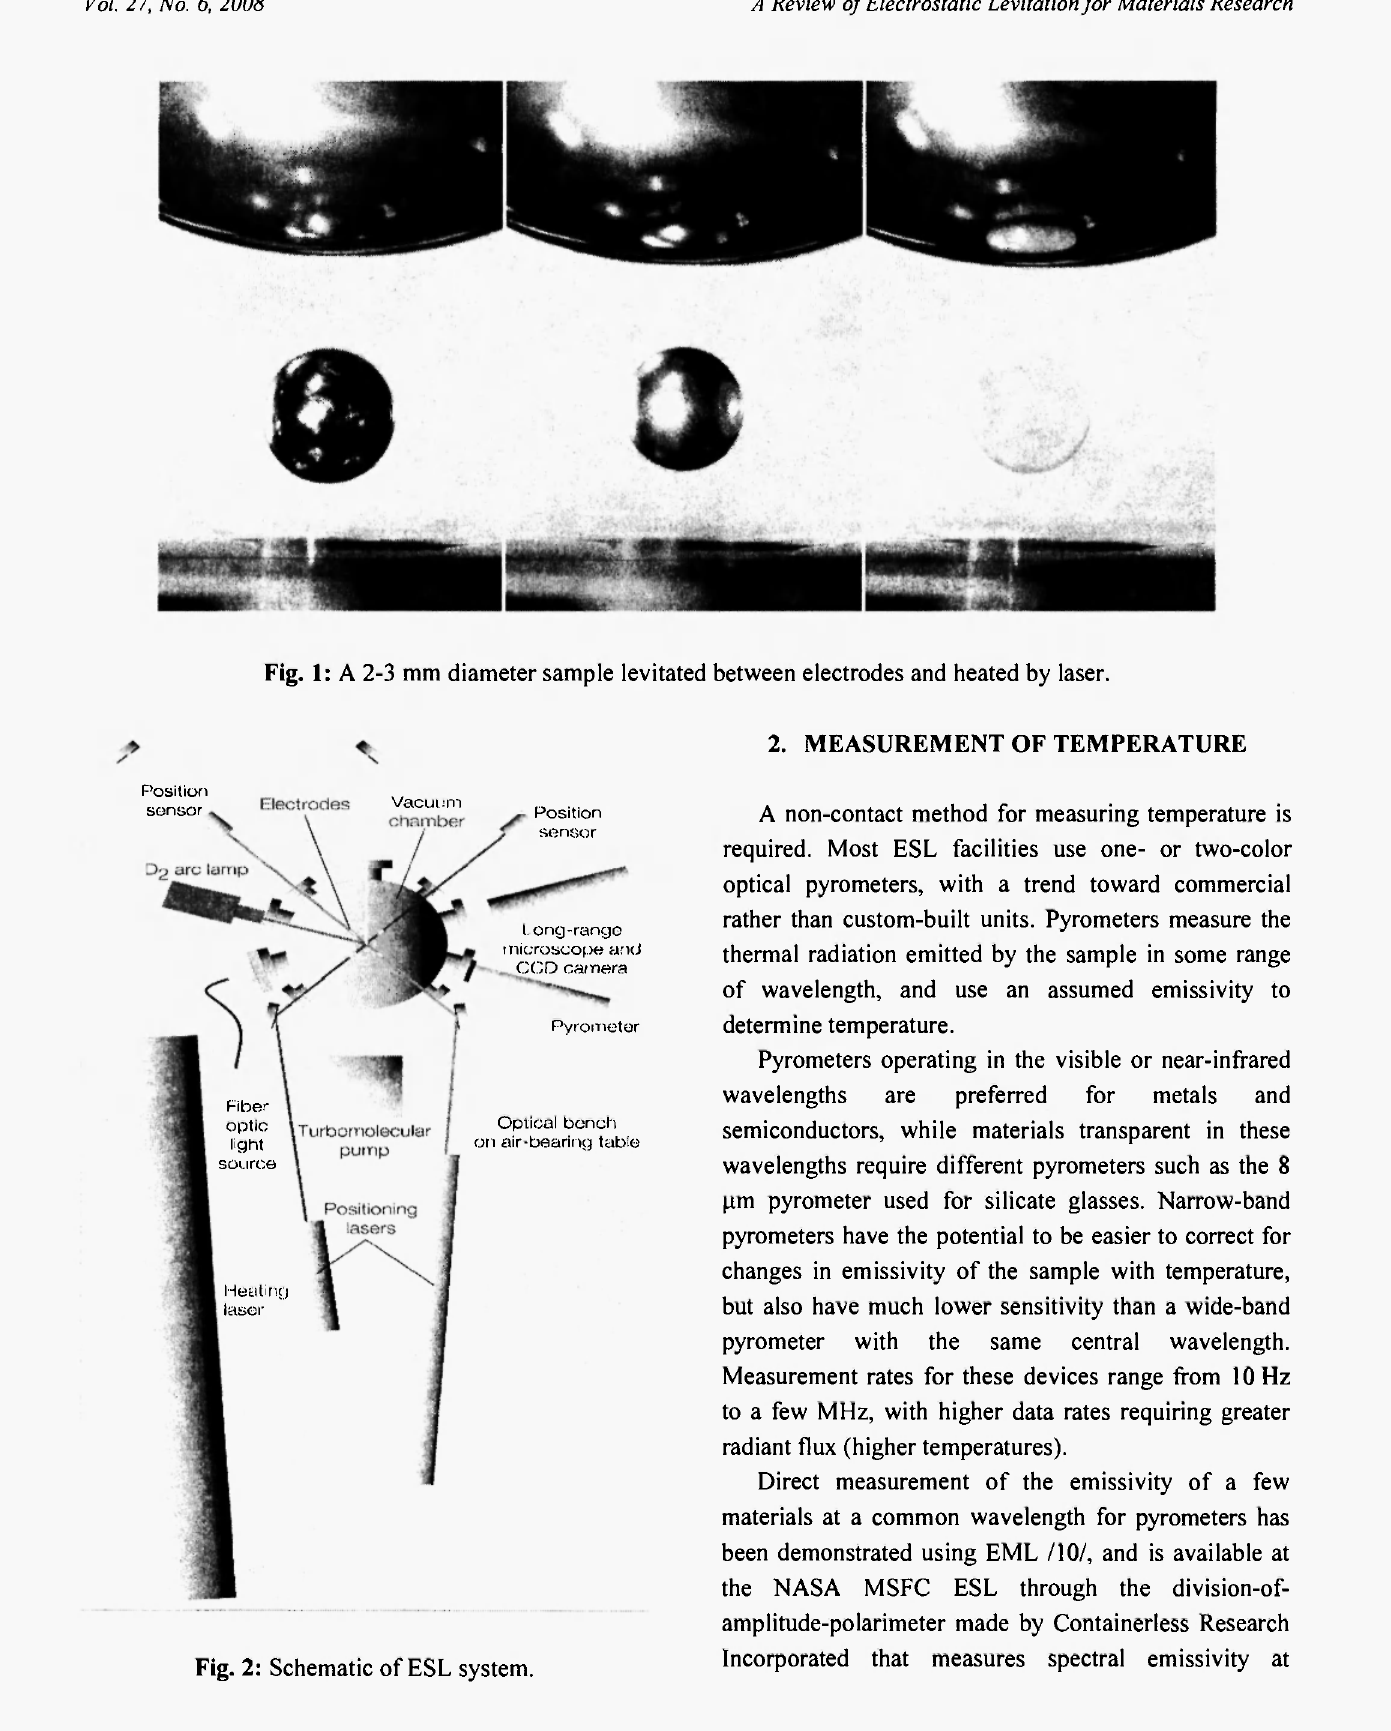
Fig. 1: A 2-3 mm diameter sample levitated between electrodes and heated by laser. 2. MEASUREMENT OF TEMPERATURE A non-contact method for measuring temperature is required. Most ESL facilities use one- or two-color optical pyrometers, with a trend toward commercial rather than custom-built units. Pyrometers measure the thermal radiation emitted by the sample in some range of wavelength, and use an assumed emissivity to determine